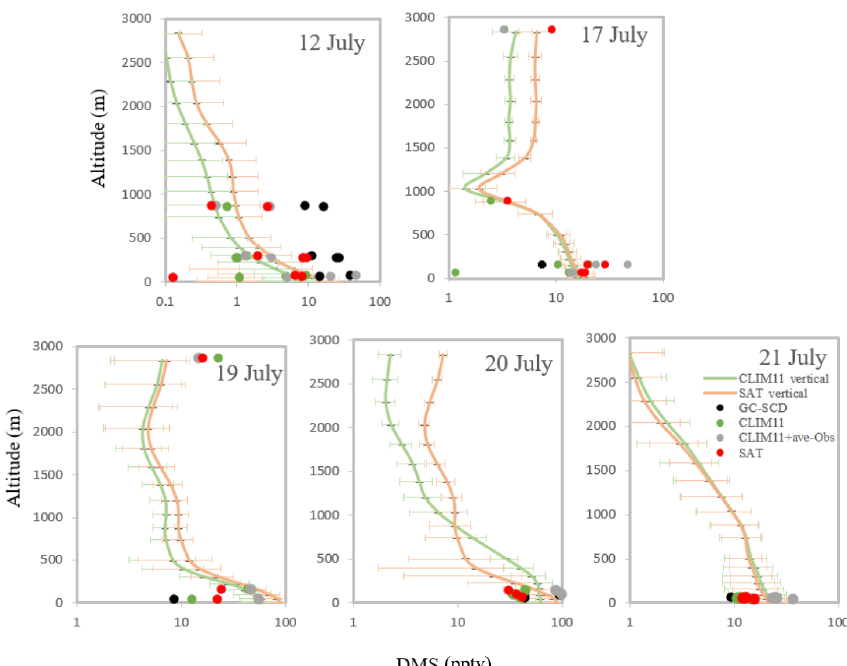
Figure 5. The dots show the atmospheric DMS concentration (pptv) from the GEM-MACH model simulations (CLIM11, CLIM11 + ave- Obs and SAT; the CLIM11 + ave-Obs simulation is defined in Sect. 4.2.3) extracted along the Polar 6 flight path coincident with observation data (GC-SCD) during July 2014. The lines show the simulated average DMS(g) vertical profiles during the flights using the SAT and CLIM11 datasets. The horizontal bars indicate the standard deviations.